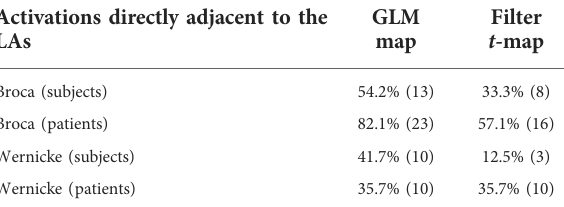
TABLE 3 Here, the frequency of the display of additional activations directly next to the LAs is compared among the